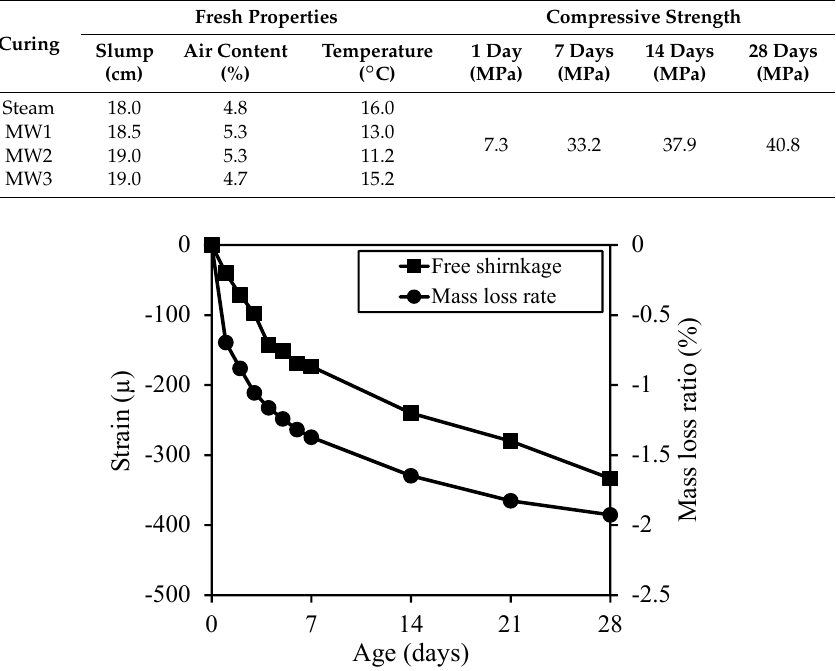
Figure 8. Free shrinkage and mass loss ratio.